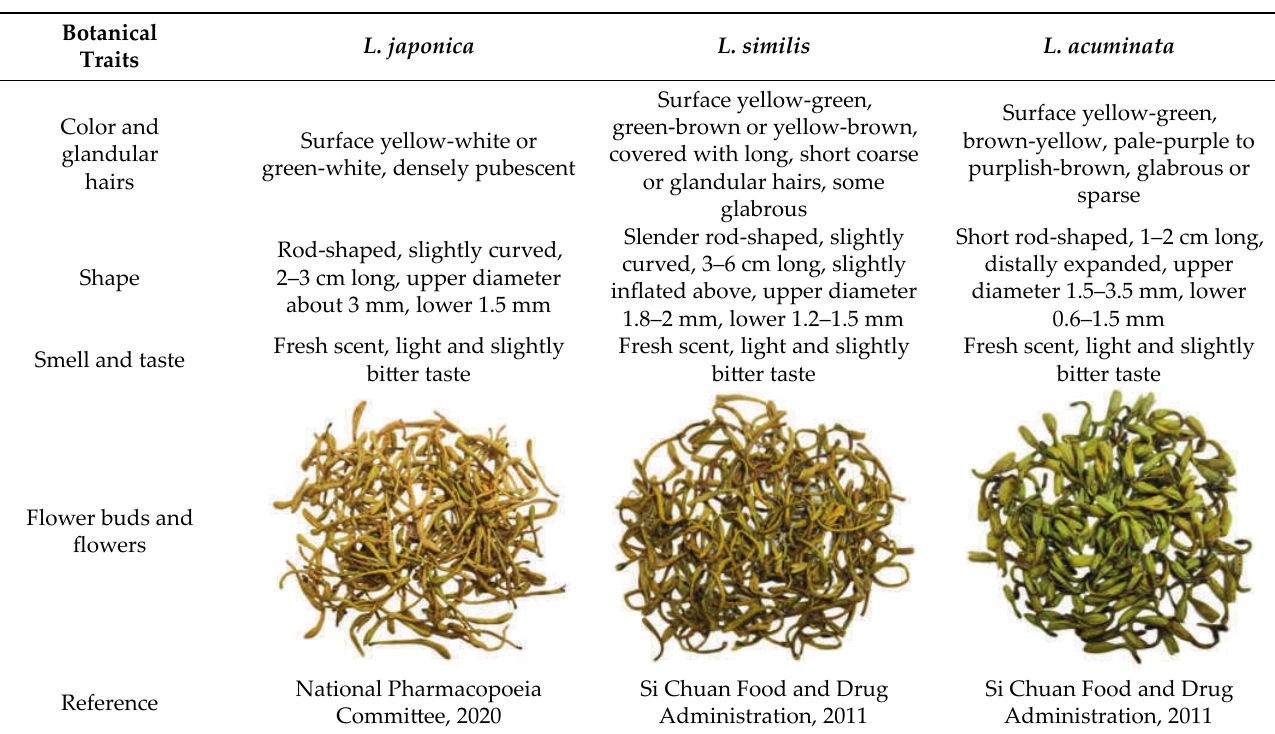
Table 2. The comparison of Botanical traits of Lonicerae japonicae flos and Lonicerae similis flos.